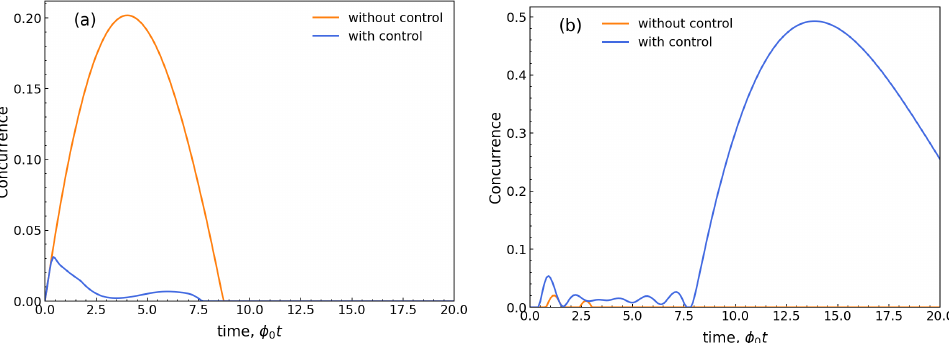
Figure 13: The evolution of concurrence of the states evolved with (a) ZZ coupling and (b) XX coupling, in presence of local dephasing, with and without control. The probe state is | + + 〉